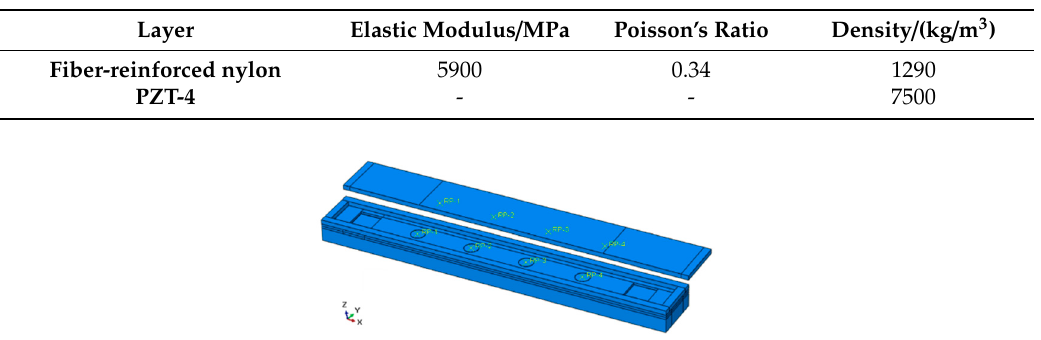
Figure 9. The piezoelectric sensing system model.